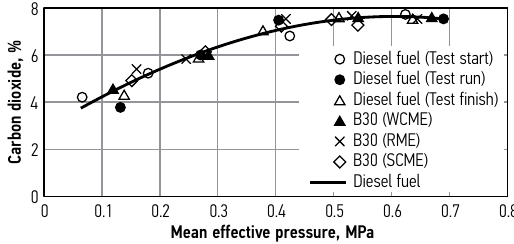
Fig. 11. The dependence of the 1Z hydrocarbon (HC) emission of the diesel engine on mean effective pressure P me